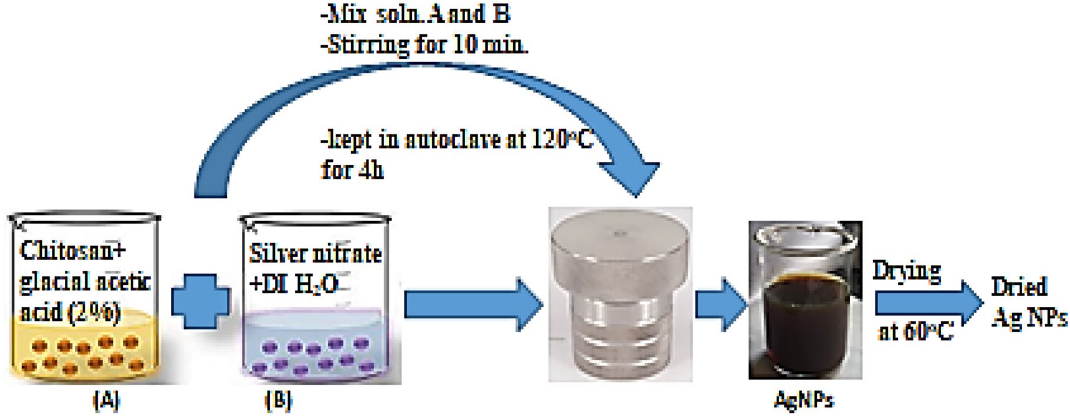
Figure 2. Representative diagram for the green preparation of Ag